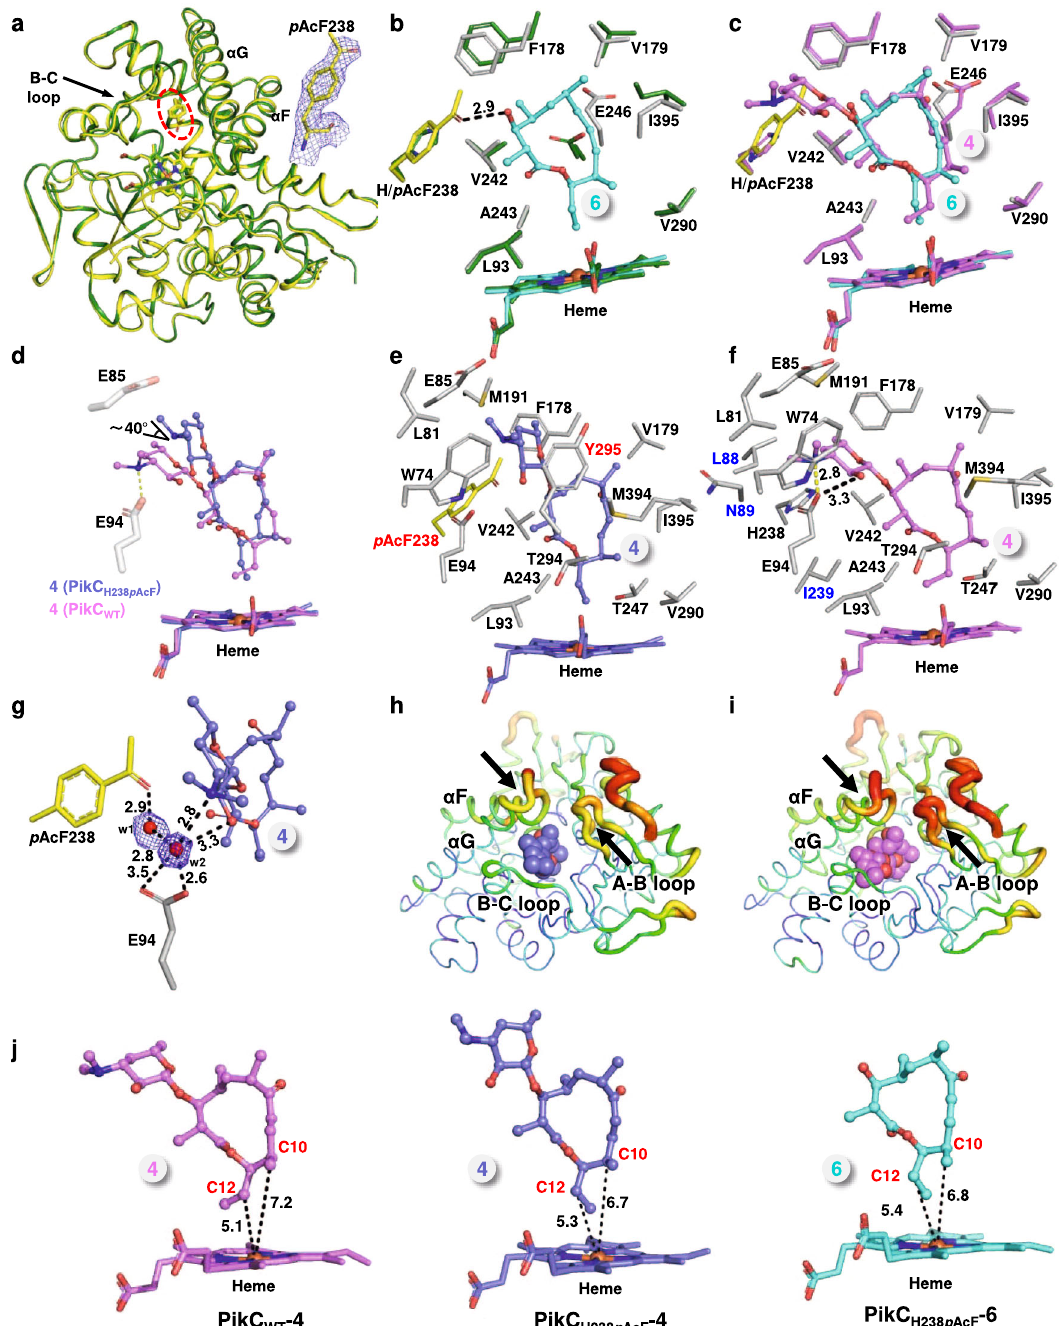
Fig. 4 | Structural analysis of substrate-free, 6-bound, and 4-bound PikC H238 p AcF . a Superposition of substrate-free PikC H238 p AcF (yellow) with PikC WT (PDB ID: 2BVJ; forest). The incorporated ncAA p AcF at H238 site is highlight as yellowstick,anditsweighted2 Fo – Fc electrondensitymapiscontouredatthelevel of 1.5 σ (blue mesh). b , c Comparisons of the substrate binding site of 6 -bound PikC H238 p AcF withthatofsubstratefreePikC WT ( b )andwiththatof 4 -boundPikC WT ( c ). The side chains of interacting amino acids are shown as sticks and colored in grey(PikC H238 p AcF ),forest(substratefreePikC WT ),andviolet( 4 -boundPikC WT ).The ncAA p AcF is highlighted in yellow. The substrates are shown in ball-stick and coloredincyan( 6 )andviolet( 4 ).Thehemegroupsarecoloredconsistentwiththe corresponding substrates. The hydrogen bond in angstrom is shown as dashed black line. d Schematic diagram of the positions of 4 in superimposed PikC H238 p AcF and PikC WT . The salt bridge formed between Glu94 and the C3 ’ dimethylamino